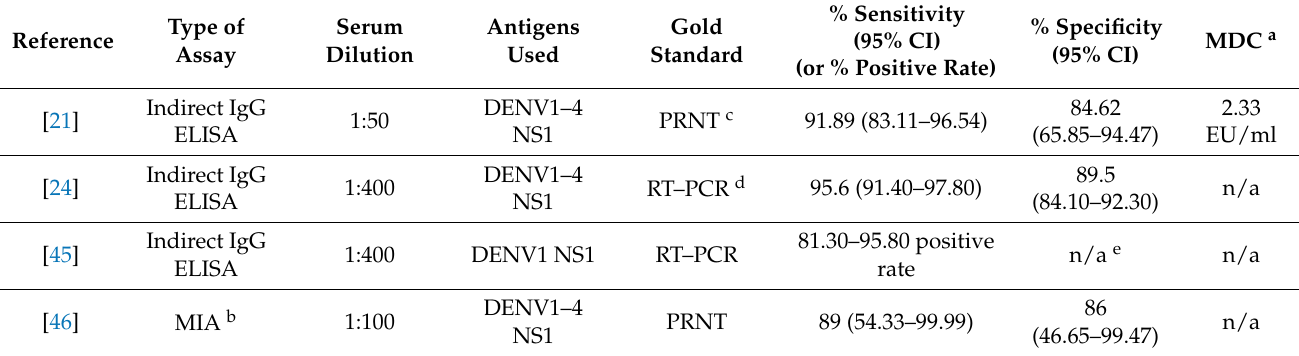
Table 3. Studies detecting anti-DENV NS1 IgG using various serological